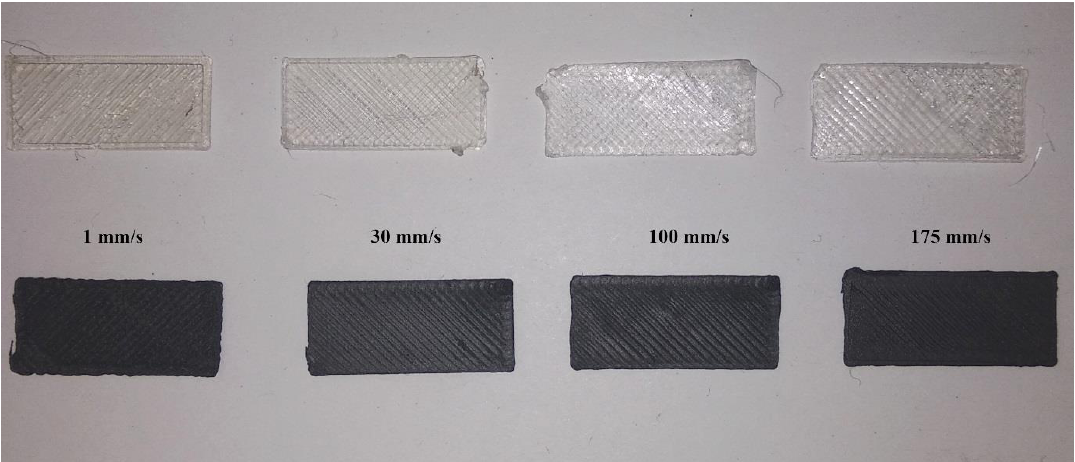
Figure 9. Printed PA6 ( clear ) and GC17.0 ( black ) at various printing speeds.